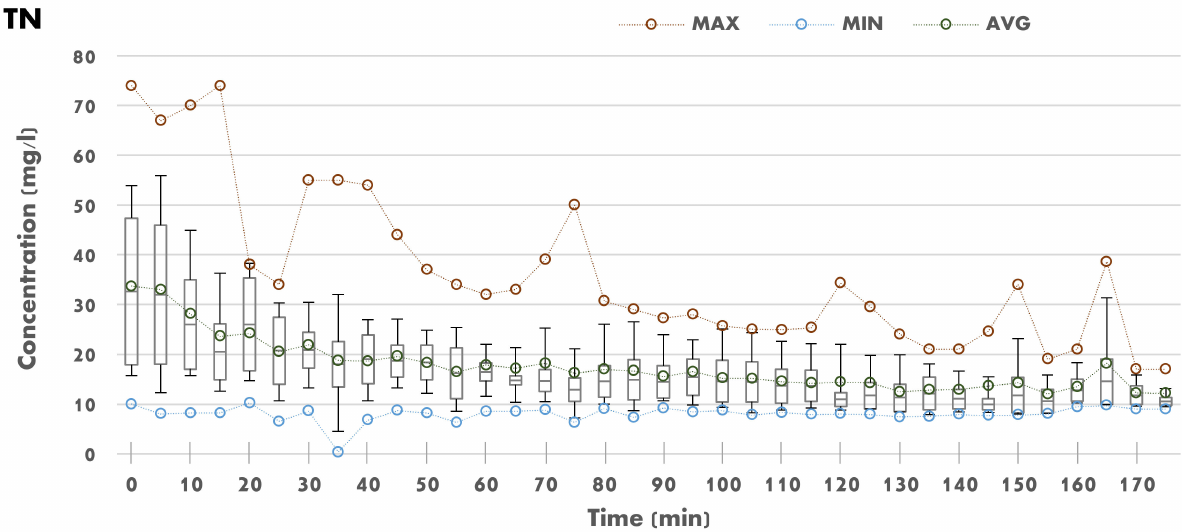
Figure 4. Moving (time) boxplot charts for COD, TSS, and TN (5-min time step) for 1400+ samples retrieved in 5 Flemish catchments. Values are stated for points outside the curve. (Produced also for BOD, TP, KJN, NH 4 , NO 2 , and NO 3 , see Figure A1 in Appendix A).